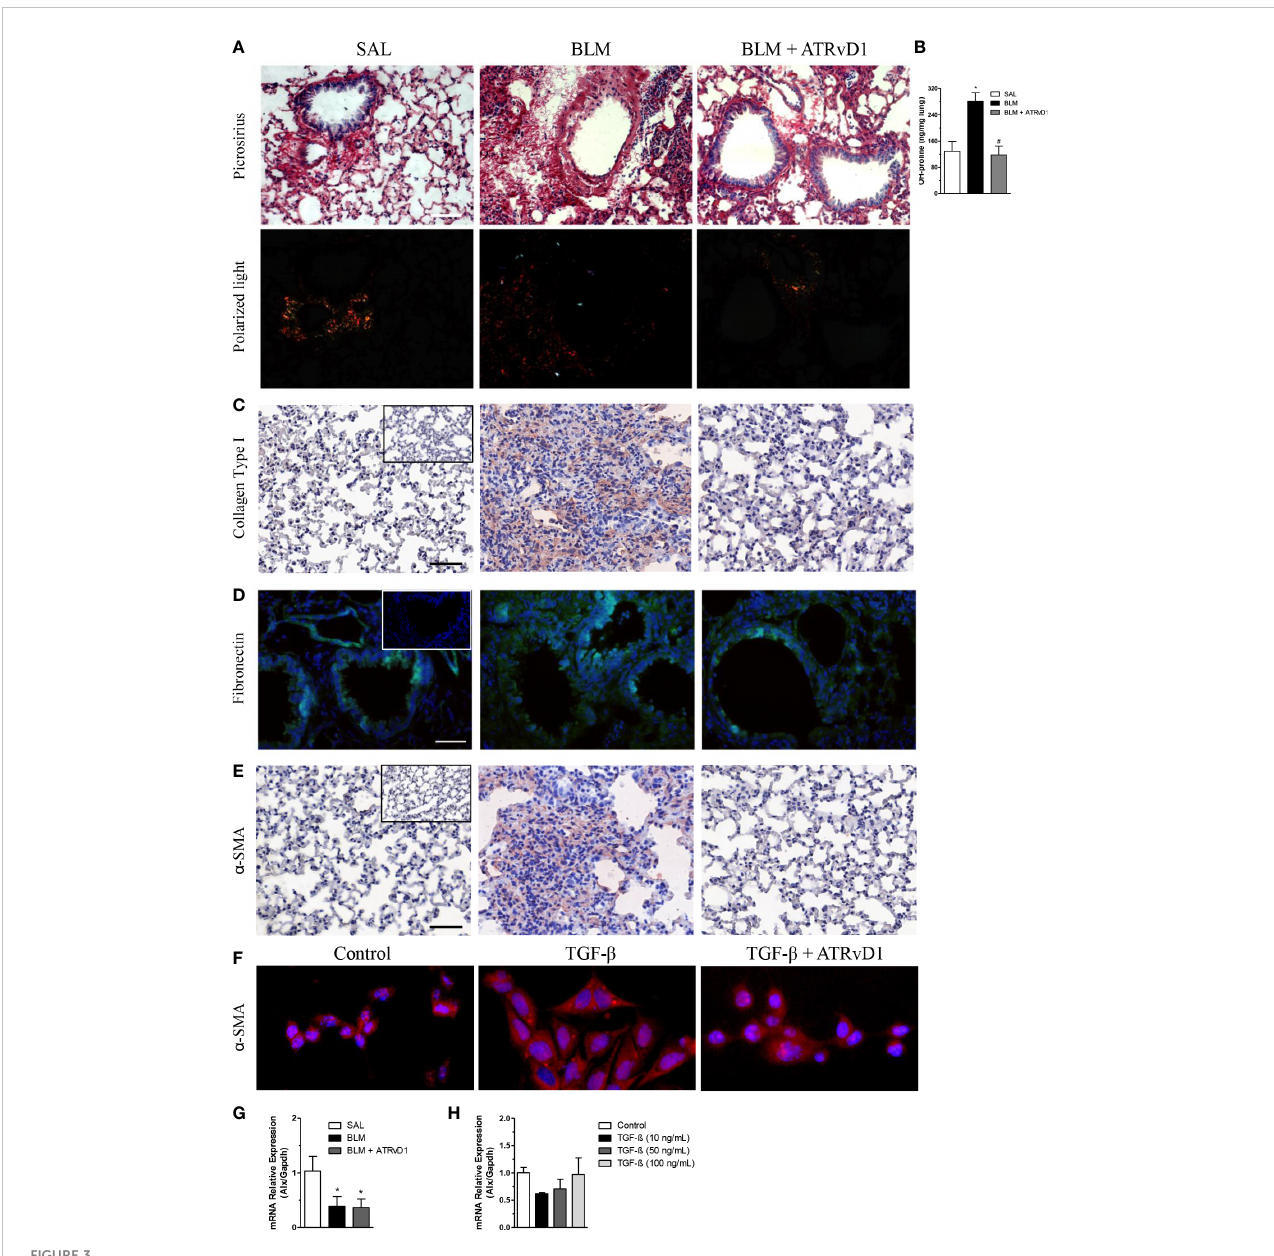
FIGURE 3 ATRvD1 impairs BLM-induced matrix protein deposition in the lung. Lungs were harvested on the 14th day after the SAL, BLM, or BLM + ATRvD1 challenges, as described in the Material and methods section. (A) Picrosirius red staining under bright fi eld (superior images) and polarized light (lower images). (B) Hydroxyproline content in the lungs on the 14th day after mice were instilled with SAL, BLM, or BLM + ATRvD1 (top right). Results are expressed as micrograms per milligram of lung tissue. * P ≤ 0.05 compared with the SAL group; # P ≤ 0.05 compared with the BLM group. (C – E) Lung sections were immunostained for collagen type I and a -SMA by immunohistochemistry and counterstained with hematoxylin or for fi bronectin and DAPI by immuno fl uorescence. (F) Primary lung fi broblasts were isolated, cultured, and incubated with the medium, TGF- b (10 ng/ml), or TGF- b + ATRvD1 (100 ng/ml) and then stained by immuno fl uorescence for a -SMA as described. Pictures are representative of each group, constituted of n = 4-5. Inserts in panels (C – E) represent the images obtained by immunostaining for the control isotype antibodies. (G, H) Total RNA was extracted from the lung tissue obtained from the SAL-, BLM-, or BLM + ATRvD1-treated mice or from the homogenate of 10 6 primary mouse lung fi broblasts incubated with medium or TGF- b at 10, 50, and 100 ng/ml. Samples were prepared using the TRIzol reagent and quantitative real-time RT-qPCR for ALX expression determined as described in the Material and methods section. Scale bar = 50 m